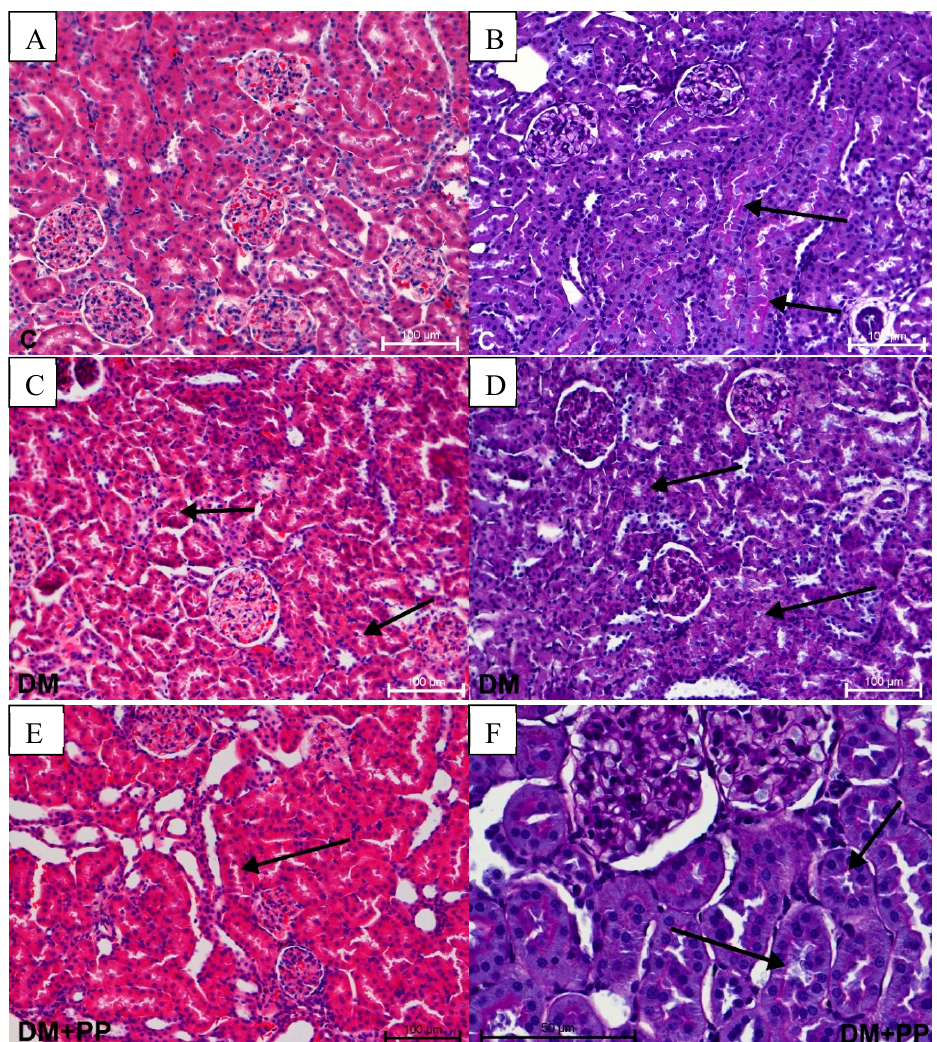
Figure 7. Histopathological studies of Blue Congo extract on the kidney tissue of STZ-induced diabetic rats. Note the presence of increased diuresis in proximal tubules (arrows) in the DM and DM + PP group photos on the left side ( C , E ). Di ff erent PAS-positive reaction (pink color) in proximal tubules (arrows), distal tubules, and capillary tuft ( D , F ). Photos on left side stained with H&E, magnification 200 × ( A , C , E ); photos on right side show PAS-positive staining, magnification 200 × ( B , D ), magnification 400 × ( F ). C—control rats (healthy rats), DM—diabetic rats, DM + PP—diabetic rats treated with Blue Congo extract for 14 days (at a dose of 165 mg / kg b.w. /